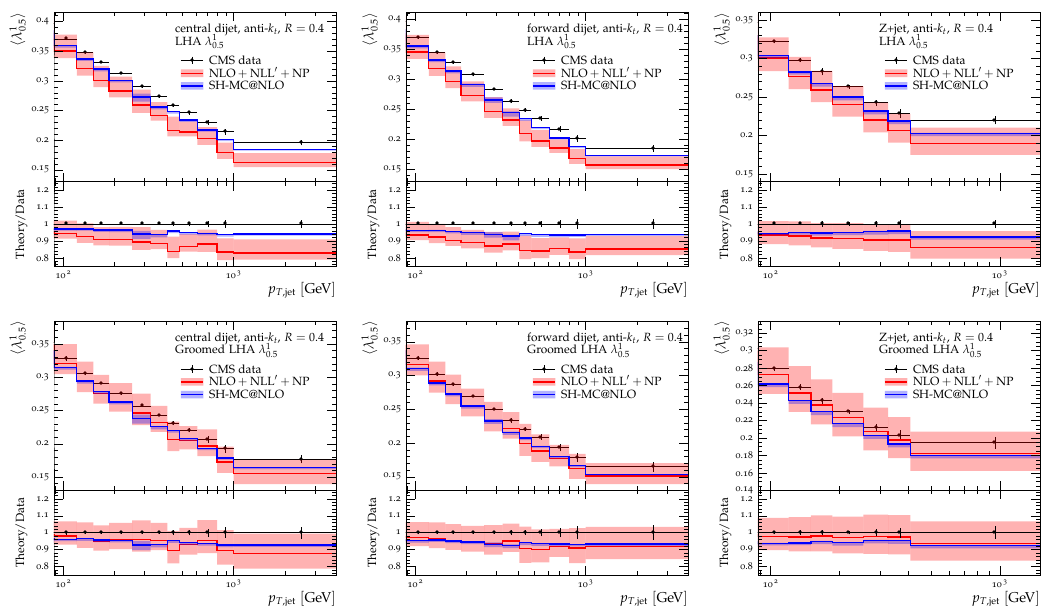
Figure 10. Results for the mean value of the Les Houches Angularity h λ 1 row) and groomed (bottom row) R = 0 . 4 anti- k t jets as a function of p T, jet . The left and middle panel correspond to the central and forward jet in dijet events, respectively, the right one to the leading jet in Z +jet